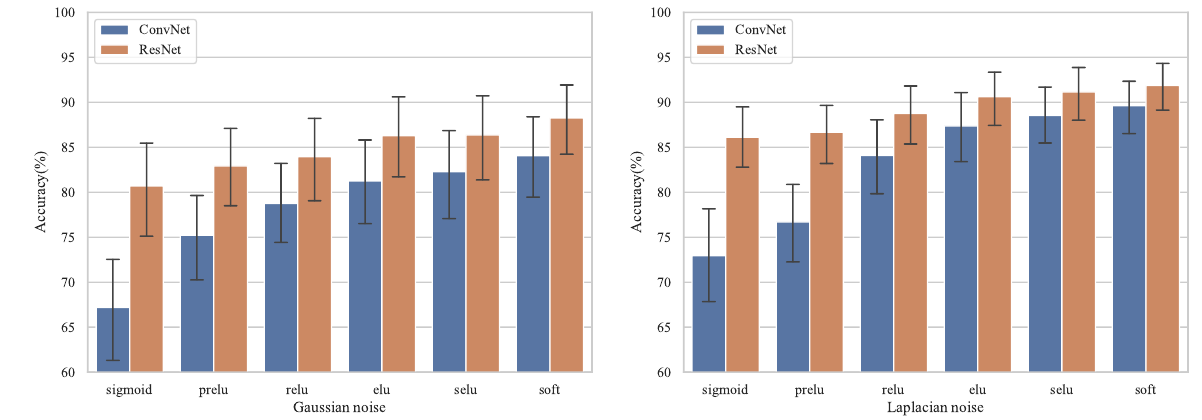
Figure 5. Overall recognition accuracy of different activation functions.